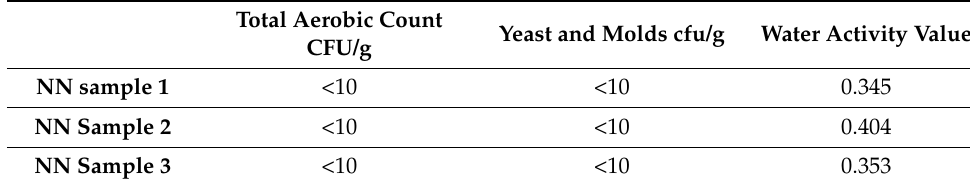
Table 5. Results for microbiological and stability